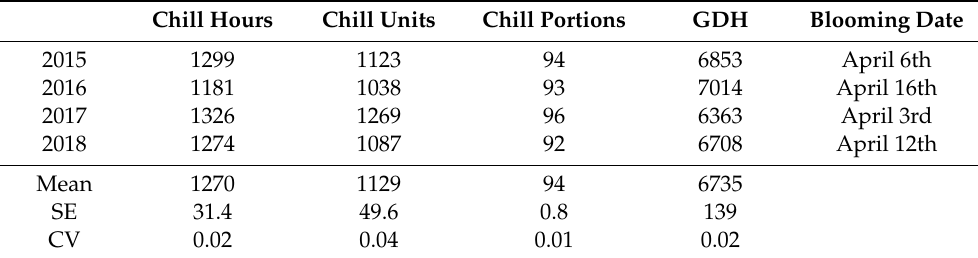
Table 1. Chilling requirements measured for the November–March period at Jumilla (Spain) and growing degree hours (GDH) between the end of dormancy and full bloom of ‘Prime Giant’ sweet cherry trees.